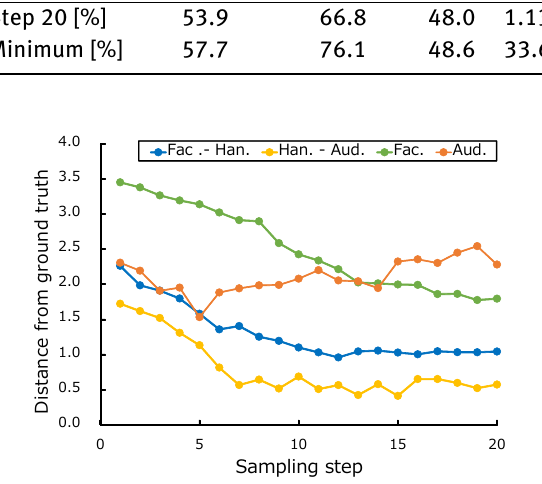
Figure 8: Transition of mean distance between a ground truth and sampled activation through 20 times the mental simulation under the Fac.-Han, Han.Aud., Fac., and Aud.